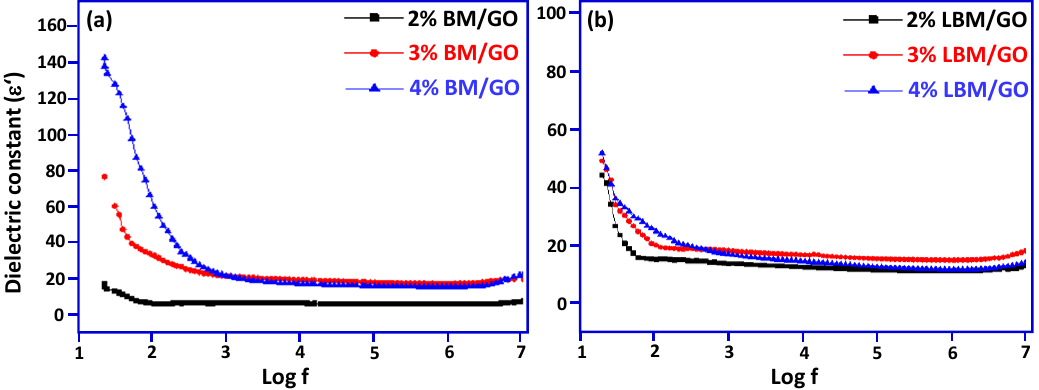
Figure 8. ( a ): Comparative graphs between the dielectric constant ( ɛ ’) and log f for composites X % BM/GO ( X = 2, 3, and 4) ( b ) X % LBM/GO ( X = 2, 3, and 4).